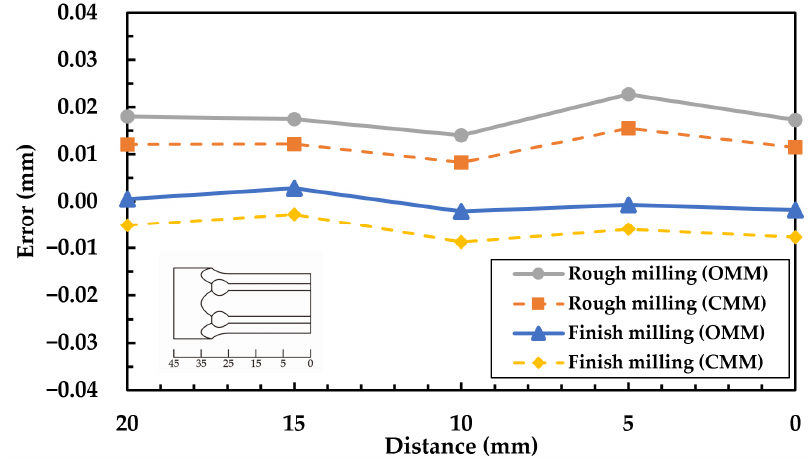
Figure 11. Machining errors along the length of the workpiece in milling machining.